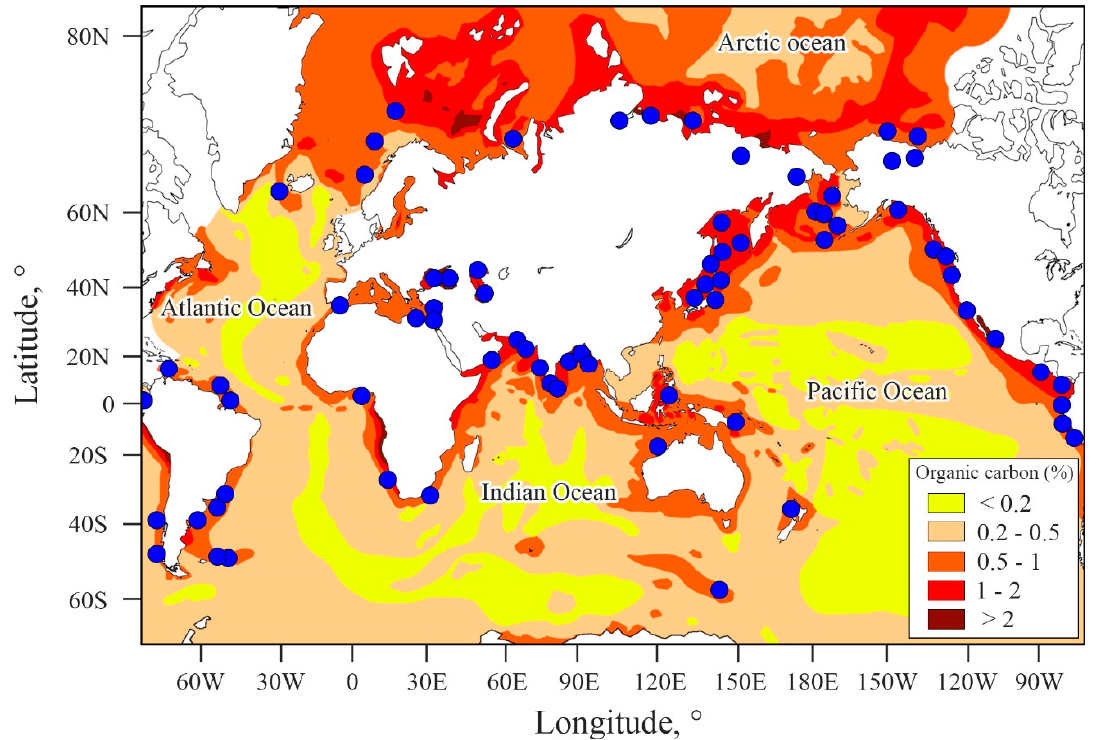
Figure 8. Distribution of C org in the surface sediments of the World Ocean (WO) (after [88]). Blue dots mark the position of discovered or predicted hydrate deposits.